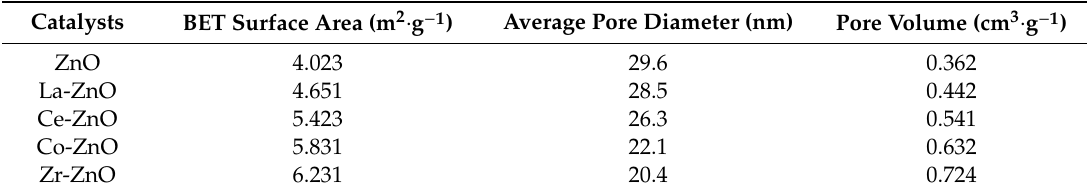
Table 2. Textural properties of ZnO catalyst modified by transition metal. Catalysts